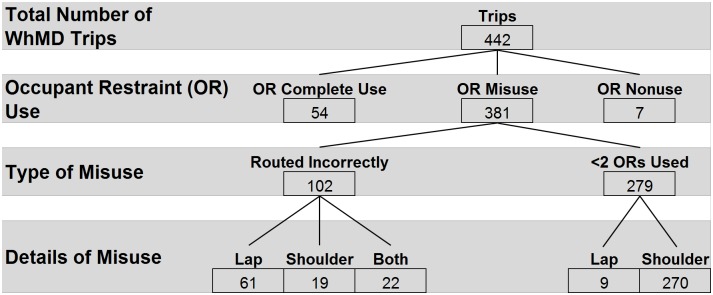
Summary of occupant restraint usage.